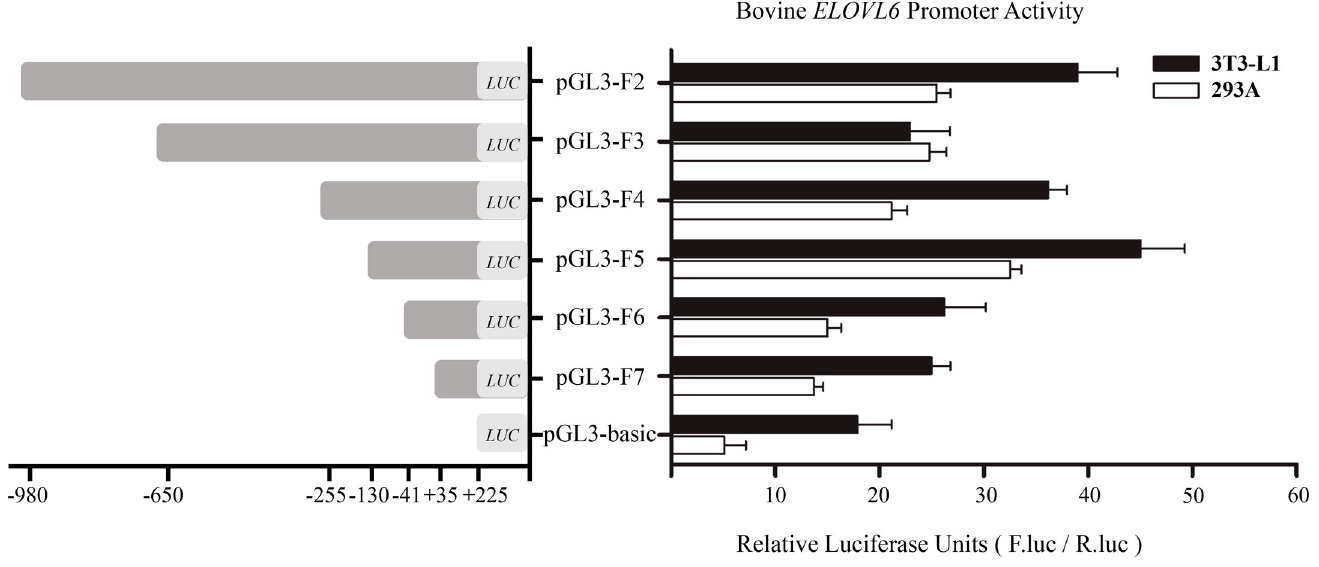
Fig 4. The structures and promoter activities of various truncation constructs of bovine ELOVL6 promoter region. The promoter activities of 3T3-L1 cells (black bars) and 293A cells (white bars) were shown as the mean ± SD of the independentexperiment performed in triplicate.